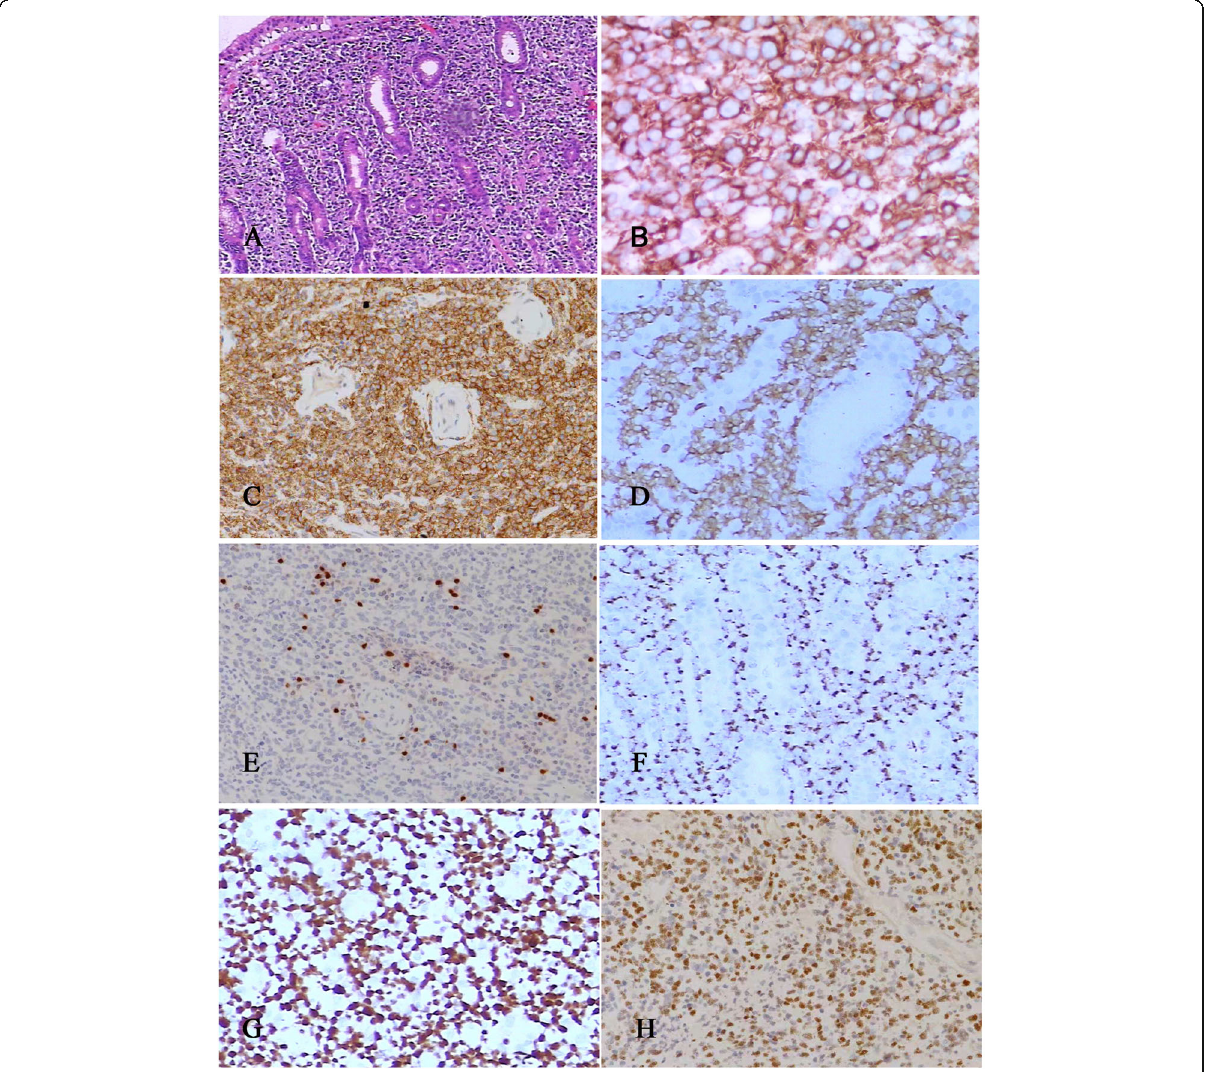
Fig. 3 Photomicrographs of the resected breast. Under the microscope, the mass showed the fibrous tissue consisted of medium to large abnormal lymphocytes, which were diffusely distributed. The tumor cells had irregular nuclei and inconspicuous nucleoli (A). Immunohistochemical analysis of the breast showed tumor cells were positive for CD20 (B), CD56 (C), CD3 (D), PAX-5 (E), TIA-1 (F). (G) The ki-67 positive rate was 90%. (H) Tumor cells were also positive for Epstein-Barr virus small-encoded RNA (EBER) by in situ hybridization (A, HE staining with original magnification ×100; B-F, immunohistochemical staining with original magnification ×200; H, in situ hybridization for EBER with original magnification